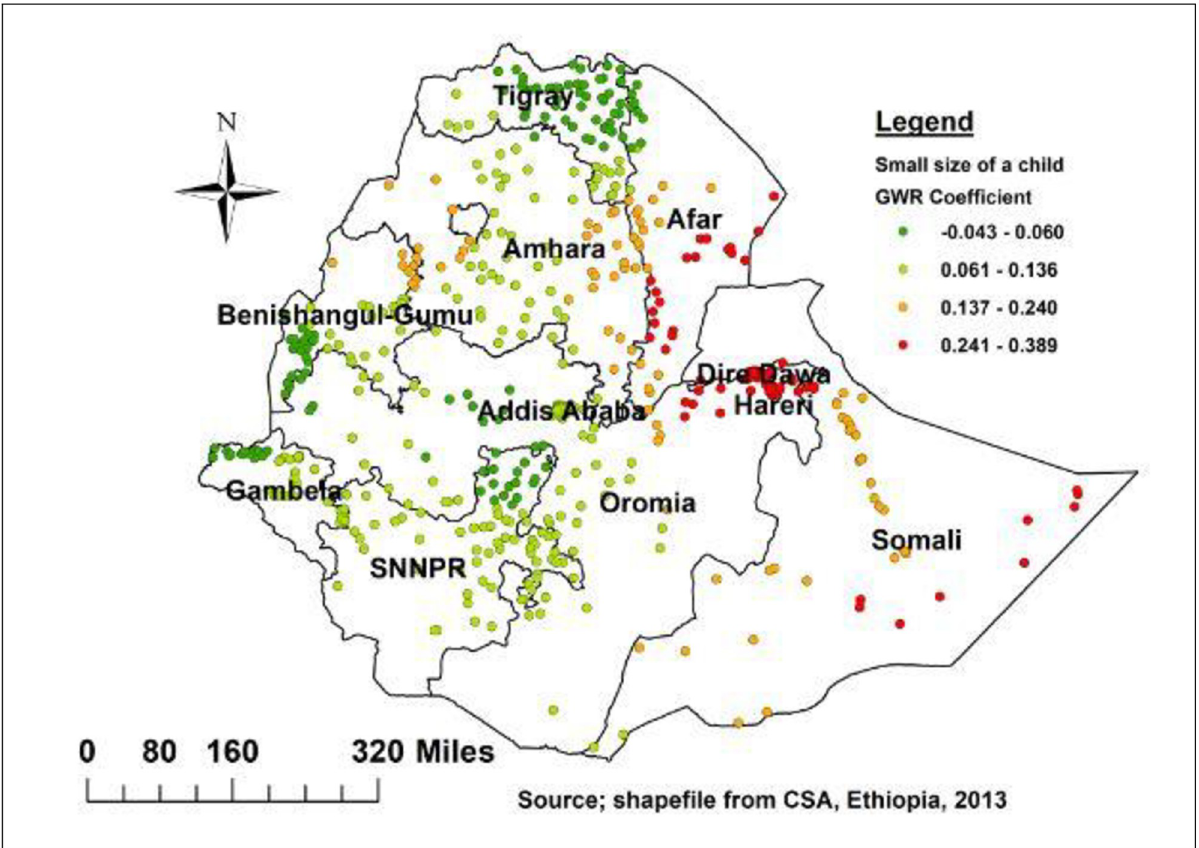
Fig 10. Small size at birth geographic weighted regression coefficients to predict delayed breastfeeding in